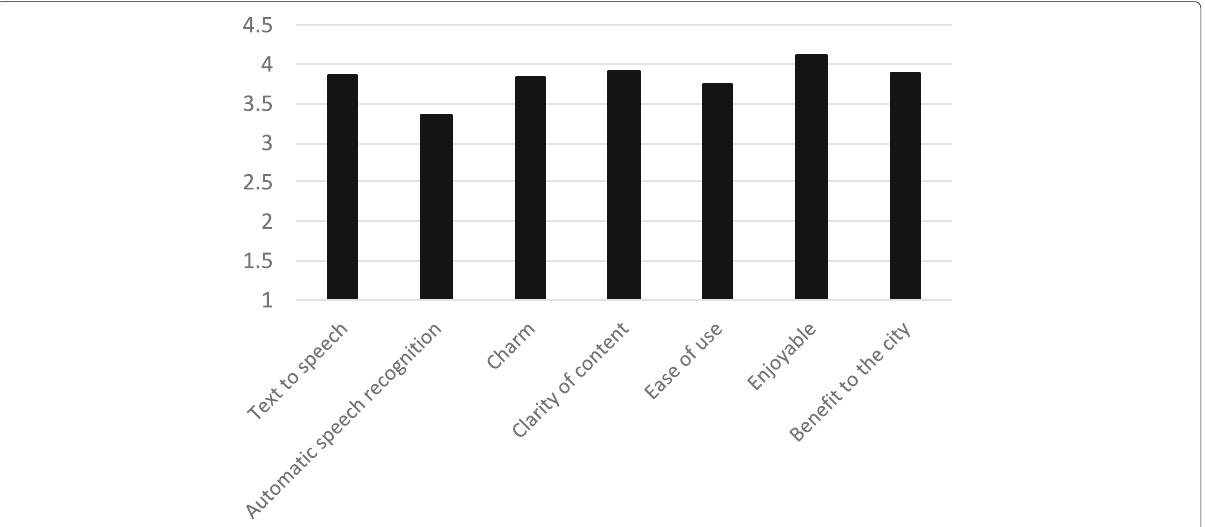
Fig. 12 Questionnaire results from Handa tourists “clarity of content” “benefit to the